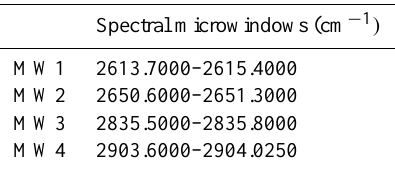
Table 1. Spectral microwindows (MW) chosen for the CH 4 retrieval shown in this study.